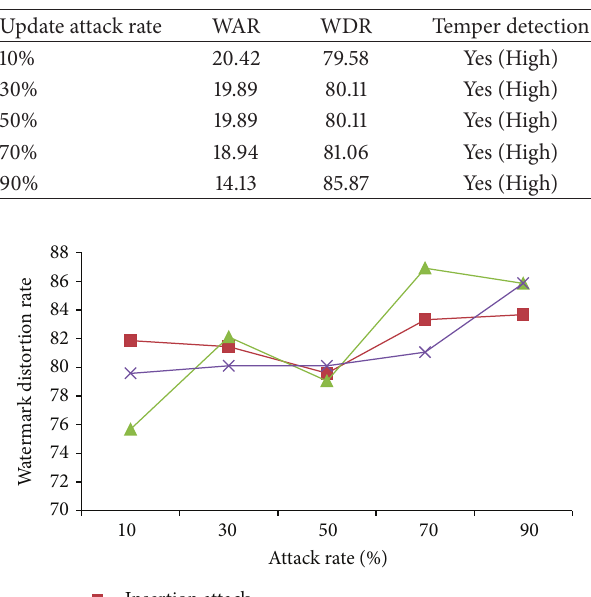
Table 4: Detection of malicious update of tuples with different attack rates ( 𝜂 = 10 6 ).